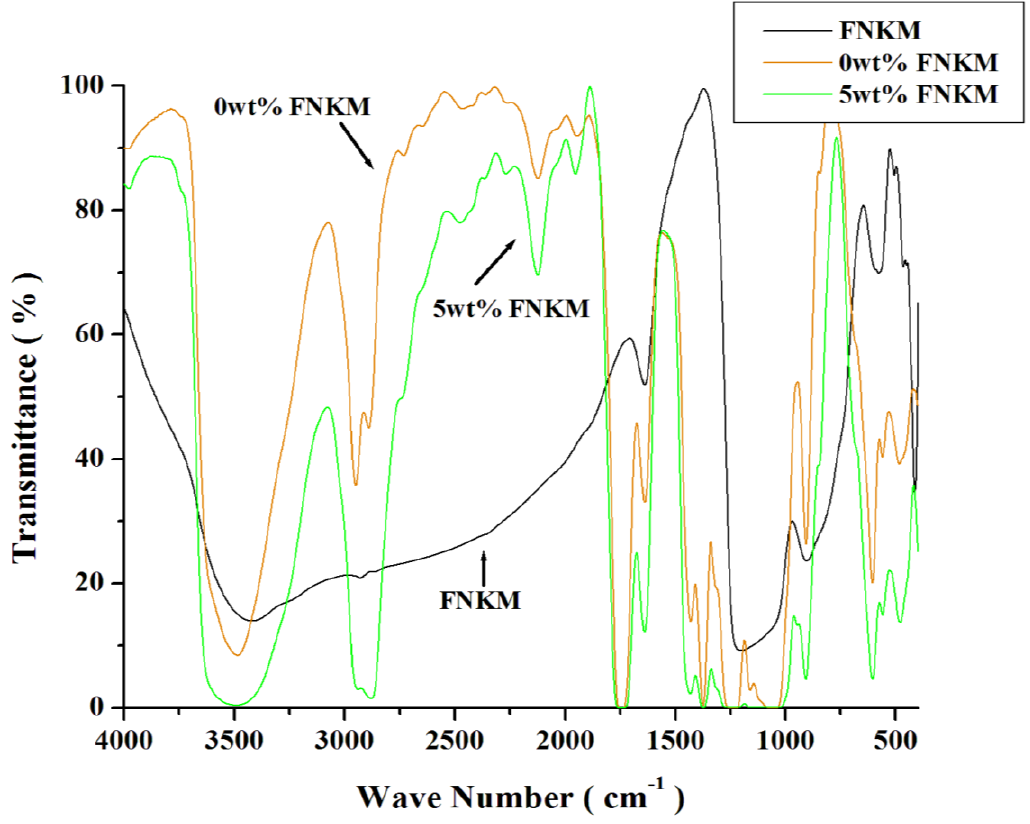
Figure 3. Fourier transform infrared spectrometer (FTIR) spectra of FNKM, 0 and 5 wt % FNKM loaded CA membranes.